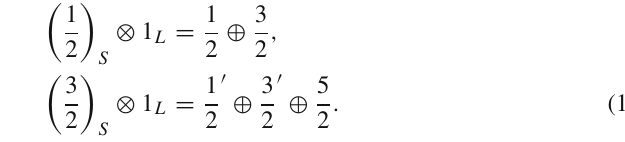
Table 1 Masses and widths of the LHCb-reported resonances Ω c [2] and Ω b [3], and excited baryons Σ Q and Ξ (cid:2) of spin-parity J P shown also. The mass and the width are in units of MeV State Mass